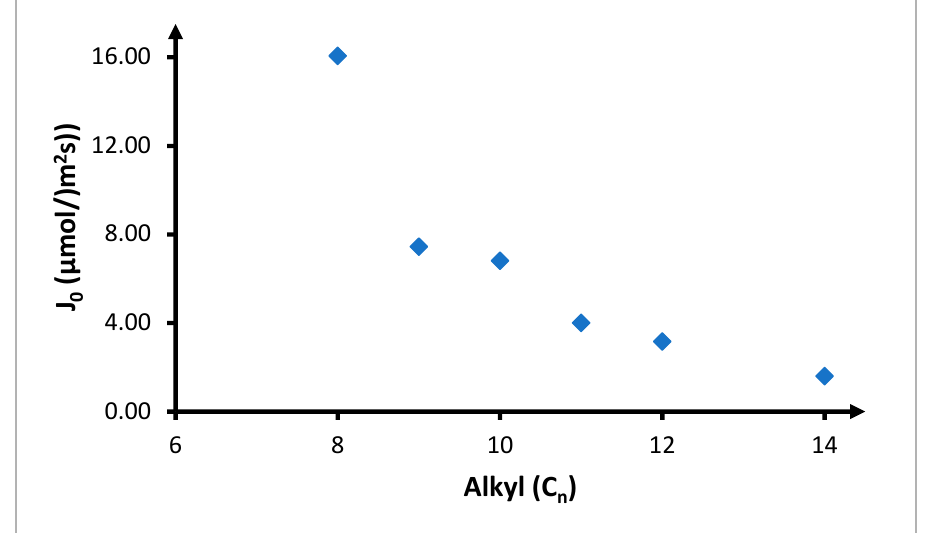
Figure 10. Effect of the chain length of the alkyl substituent on the initial flux of copper(II) ions. The volumetric flow rate is 3.0 cm 3 /min. Feeding phase: CuCl 2 concentration—0.1 mol/dm 3 , chloride concentration—2.0 mol/dm 3 . Receiving phase: demineralized water. Membrane: CTA-ONPOE-TRIA-10. The composition of the membrane is provided in Table 2. Temperature 20 ± 0.5 °C.